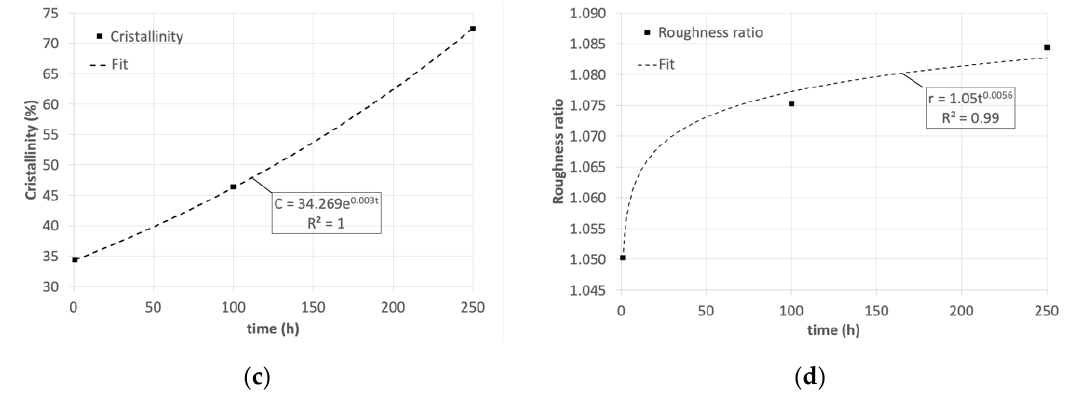
Figure 3. Evolution over time of ( a ) the EIS contributions; ( b ) thickness of the interaction layer; ( c ) crystallinity and ( d ) the roughness ratio. Data plotted as empty triangles in ( a ) were not taken into account for fitting the P-II trend.